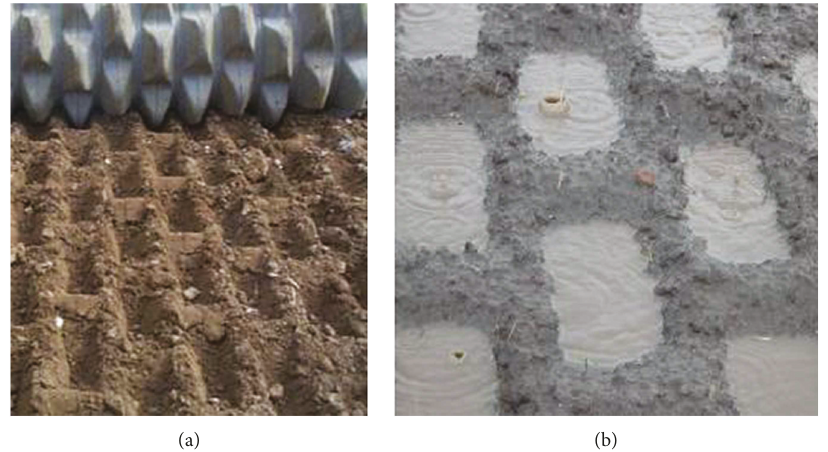
Figure 2: Imprinted soil surface for water harvesting. (a) Imprinted soil surface. (b) Microbasin for water